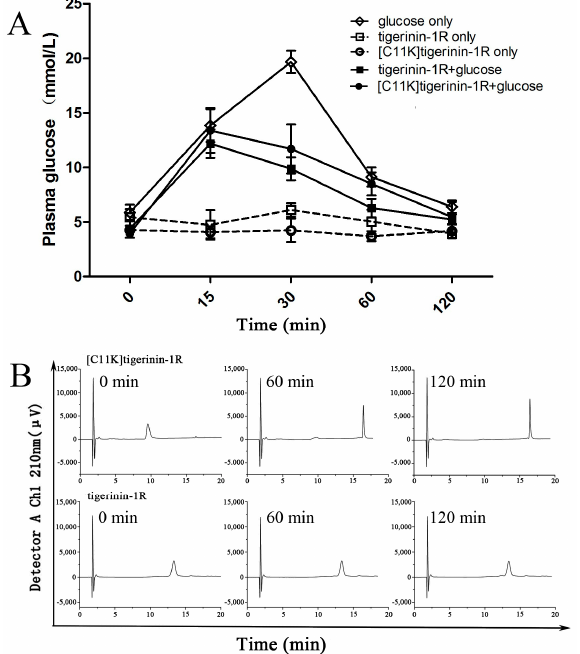
Figure 5. In vivo study and stability of peptides in 10% fetal bovine serum. ( A ) Effect on plasma glucose concentrations of tigerinin-1R and [C11K]tigerinin-1R (75 nmol/kg body weight) in lean mice. Glucose (18 mmol/kg body weight) was administered with or without the peptides by intraperitoneal injection. Values are mean ± SEM ( n = 6). ( B ) Stability of tigerinin-1R and [C11K]tigerinin-1R in 10% fetal bovine serum. The remaining intact peptides were detected by reversed-phase high performance liquid chromatography (RP-HPLC) after incubation with 10% fetal bovine serum for different times.